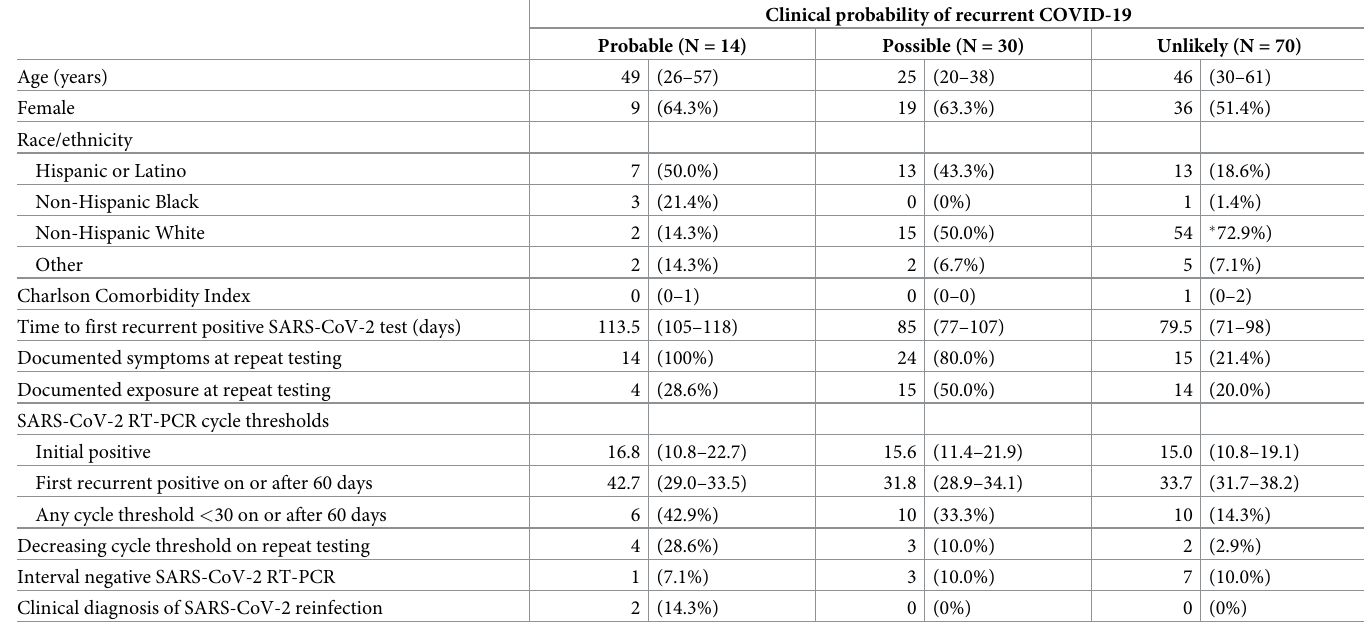
Table 3. Subject characteristics by clinical likelihood of